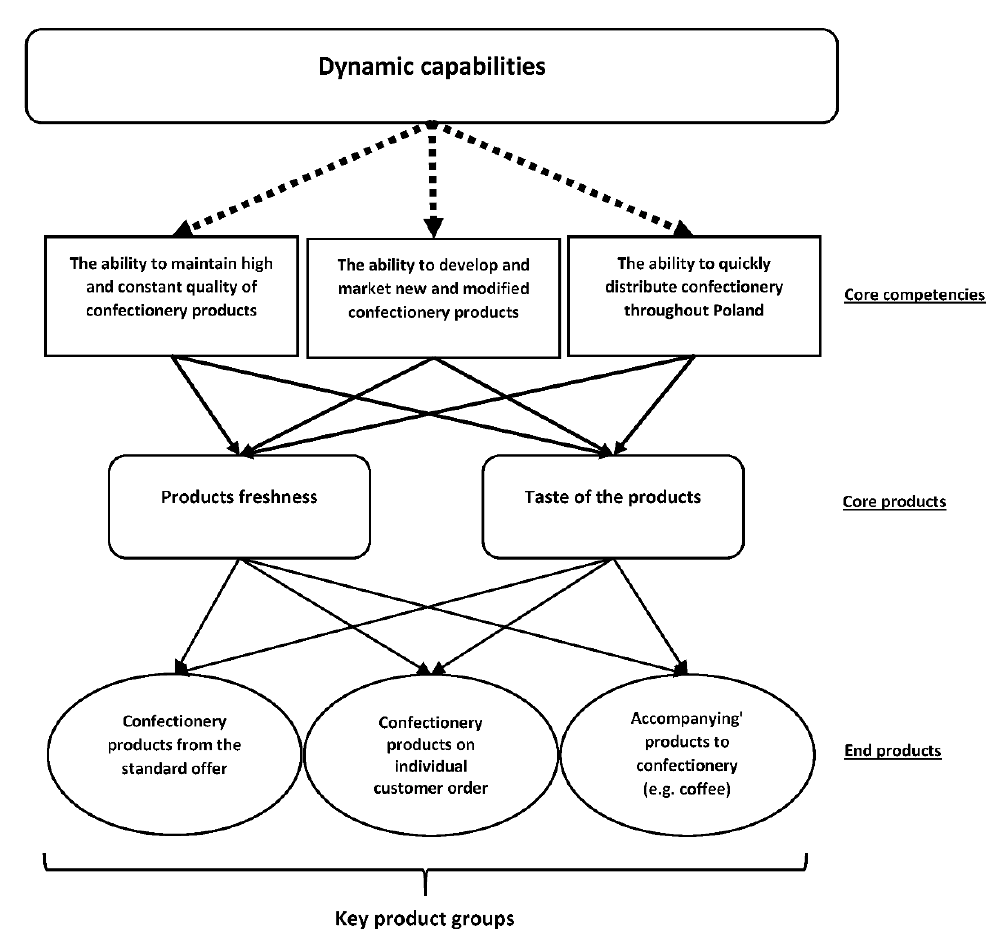
Figure 5. Relationship between dynamic capacities, core competencies, core and end products of Cukiernia Sowa.